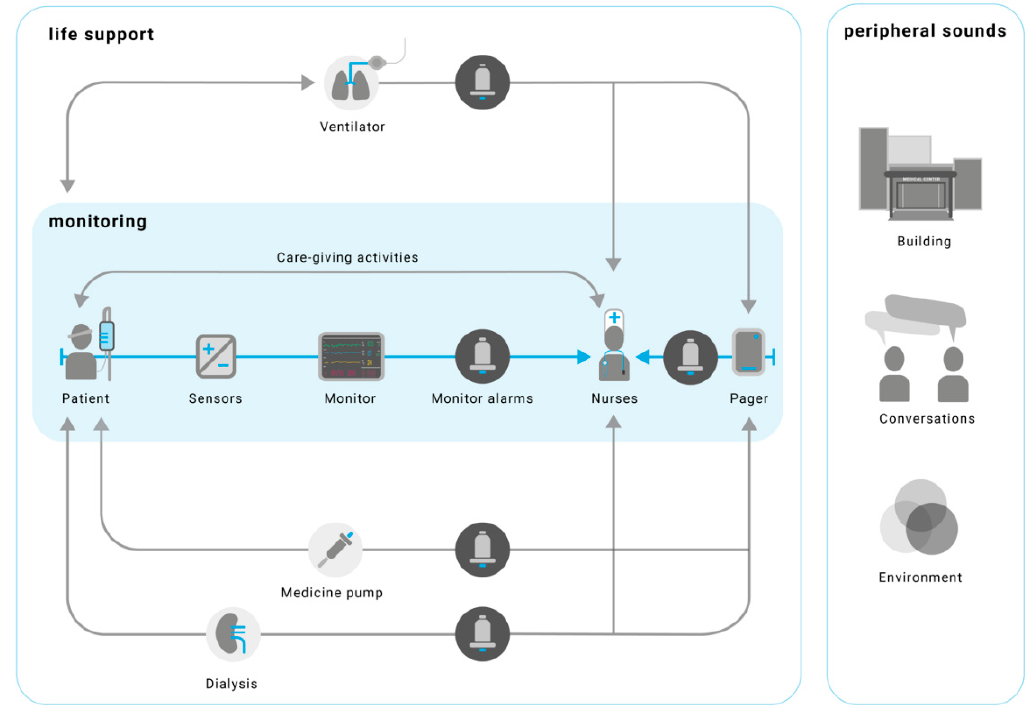
Figure 2. Insight into the distribution of the sound producing events over the critical care sound categories (Figure adopted from Bogers [34]).